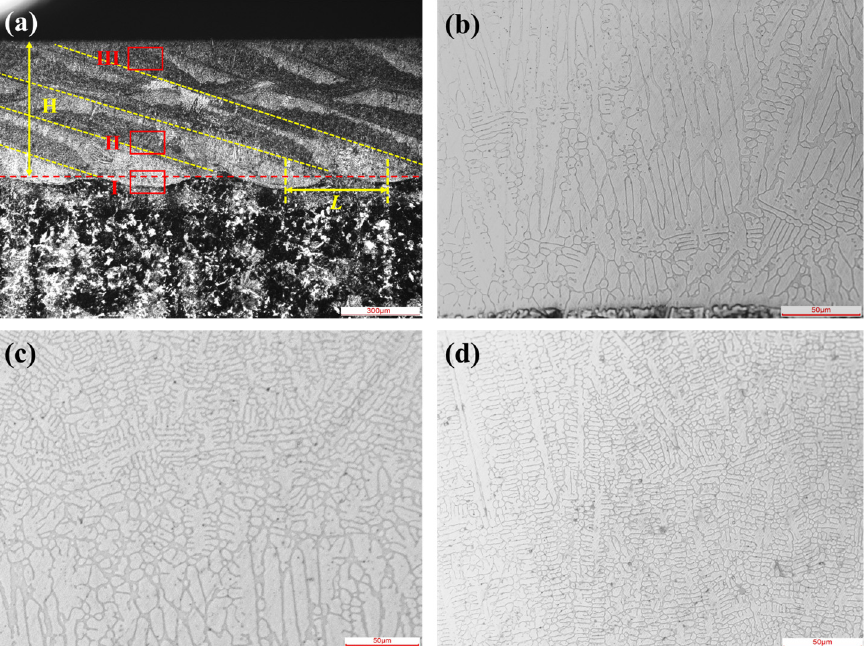
Figure 10. Microstructure of EHLA JG-11 coating. ( a ) Overall micro-morphology of coating; ( b ) micro-morphology of coating/substrate interface (zone Ⅰ ); ( c ) micro-morphology of overlapping area inside the coating (zone Ⅱ ); ( d ) micro-morphology of near-surface layer of coating (zone Ⅲ ).